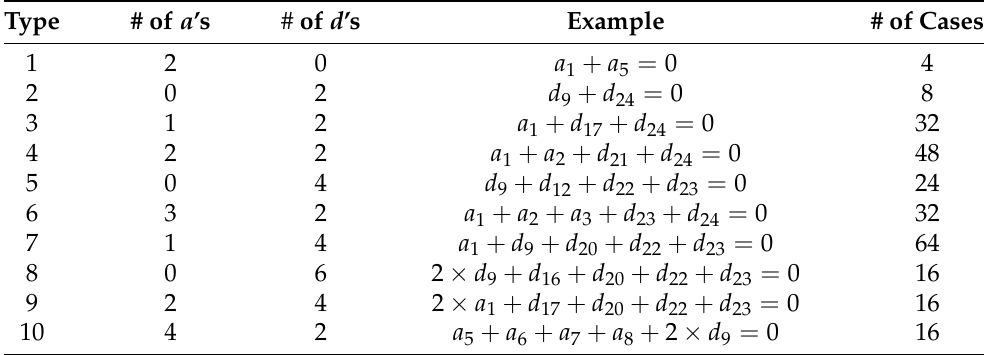
Table 2. Types of the elements of the Hilbert basis.